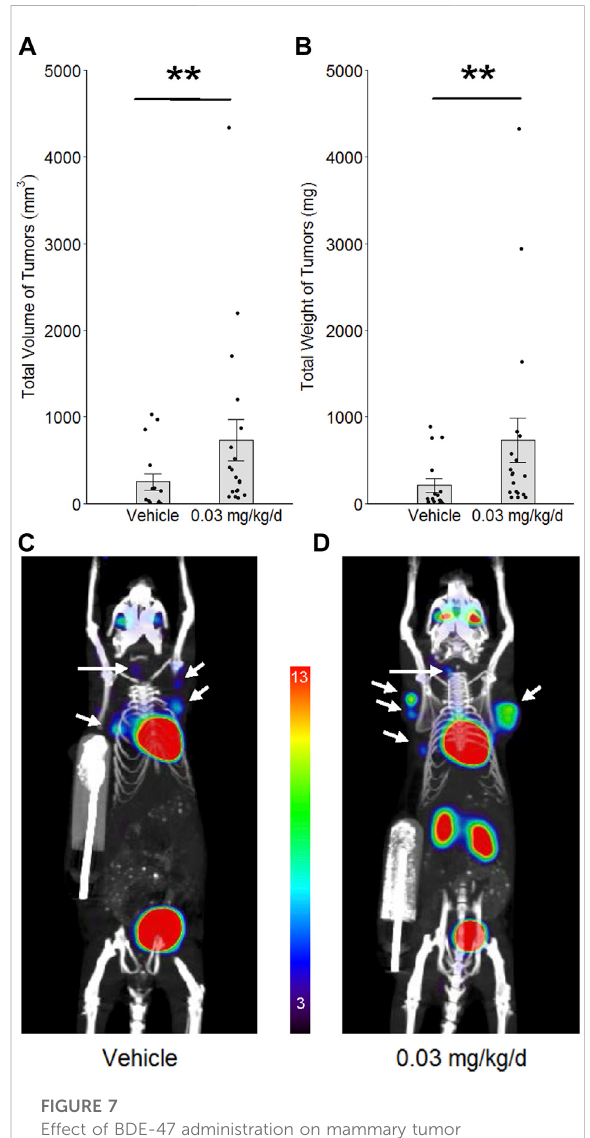
FIGURE 7 Effect of BDE-47 administration on mammary tumor development in the C3(1)/TAg model. Mean ± SEM and individual data points for (A) total volume of tumors and (B) total weight of tumors. Representative 10 mm 2D coronal slices, in maximum intensity projection (mip), from 3D PET/CT images of micerandomized to (C) onlyvehicle( n =16) and (D) 0.03 mg/kg/d ofBDE-47( n =19).Whitearrows indicatemammarytumors.Color scale is % ID/g, with threshold set to 3%; note that heart and bladder (and kidneys in the more dorsal 2D slice of panel D) serve as positive control tissue for [ 18 F]-FDG in this scan protocol, with % ID/g > 13. ** p <